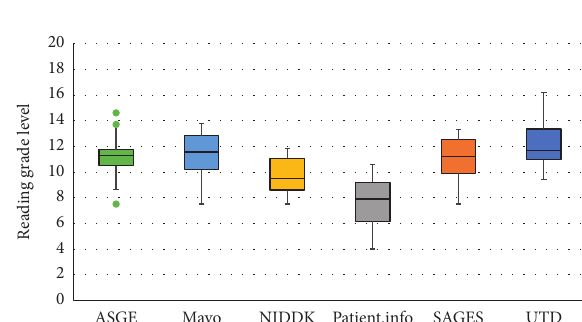
Figure 1: The overall reading grade distribution on a box and whisker plot for colonoscopy, flexible sigmoidoscopy, and EGD. The median for colonoscopy is 9.7 with a minimum and maximum of 5.5 and 17.1, respectively. The median for flexible sigmoidoscopy was 10.2 with a minimum and maximum of 3.7 and 20, respec- tively. Finally, the median for EGD was 11.0 with a minimum and maximum of 4.0 and 16.2.